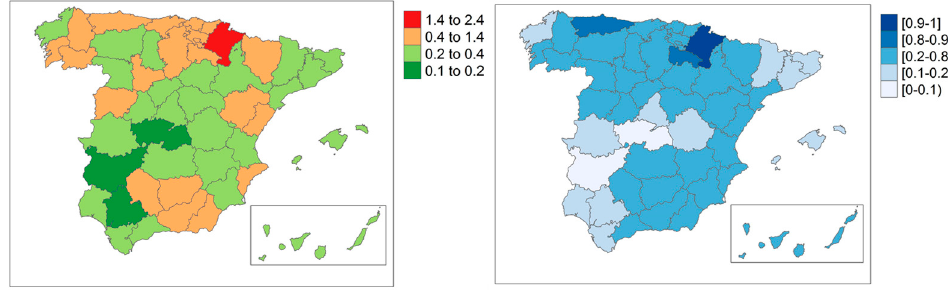
Figure 2. Province-specific rates of tractor fatalities. Posterior mean estimates ( left ) and posterior exceedance probabilities of that rates being higher than the overall rate for Spain ( right ).